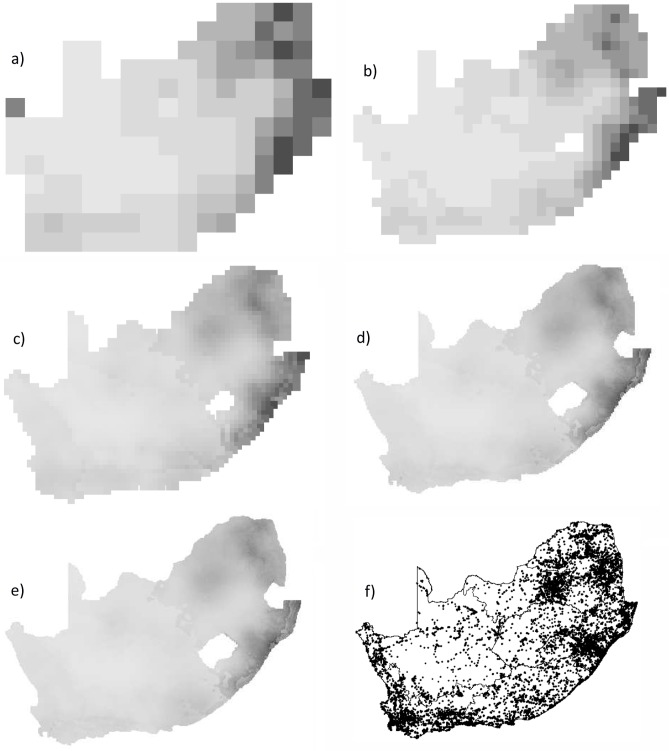
Modelled median total richness for South African butterflies at five grid square scales.Modelled median total richness (Spatial Model 1) for butterflies in South Africa at five grid square scales: a) 60 minutes, b) 30 minutes, c) 15 minutes, d) 5 minutes and e) 2 minutes. Higher richness is represented by darker shades of grey. In f), point localities of all butterfly distribution records (n = 326 530) in the atlas region (South Africa, Lesotho and Swaziland) which emanated from the SABCA project [30] are shown.